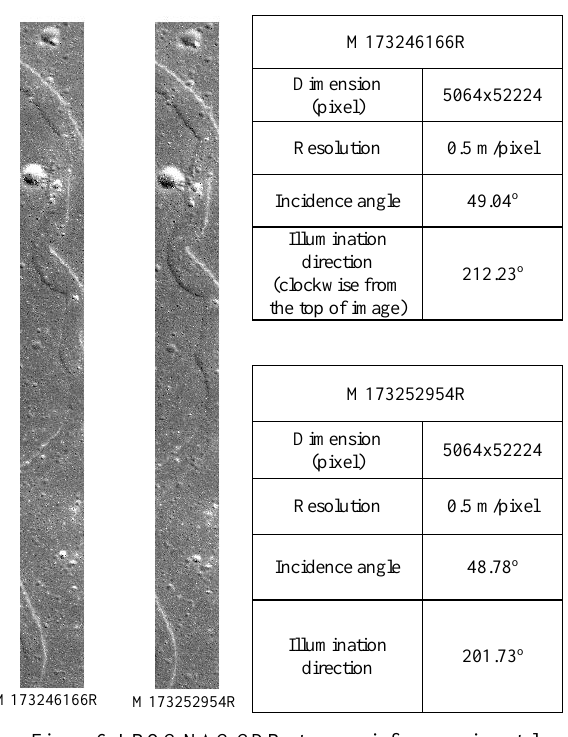
Figure 6. LROC NAC CDR stereo pair for